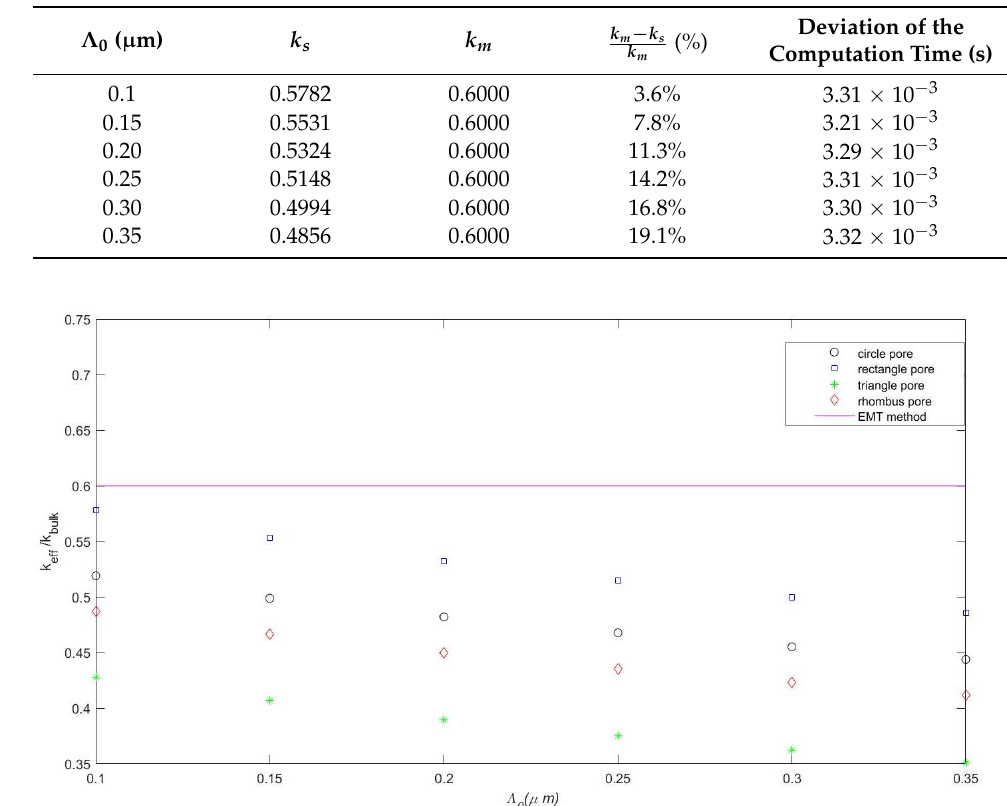
Figure 4. The effective thermal conductivity with the EMT method and the MCBU method with the changes of Λ 0 .